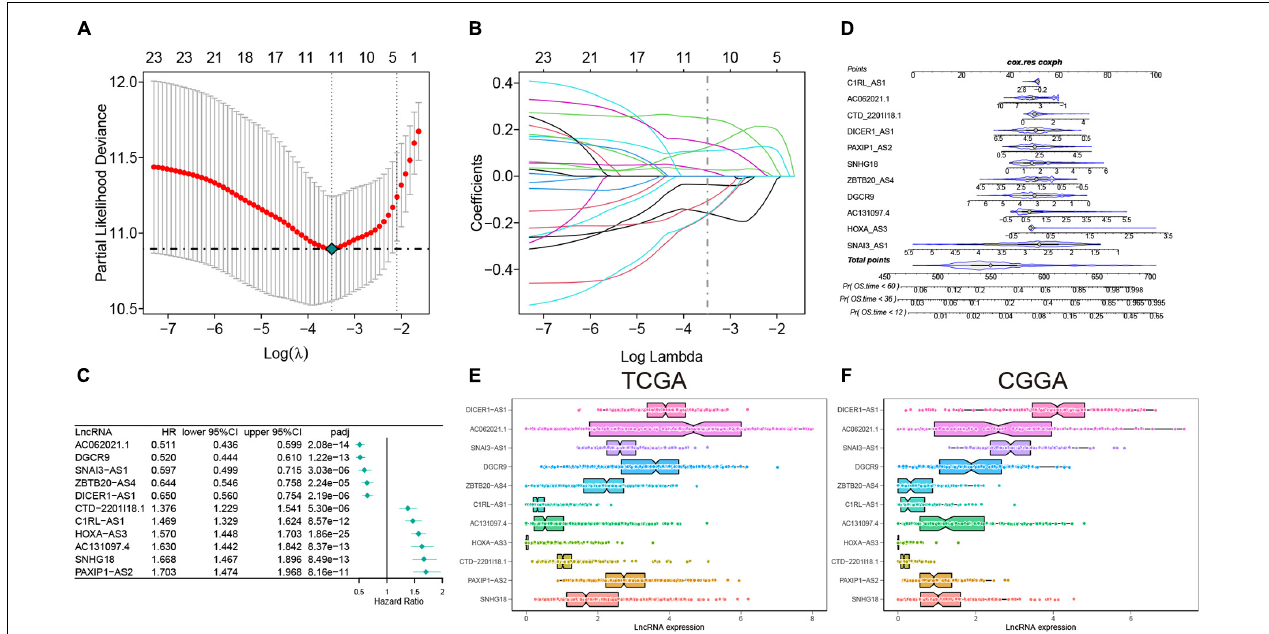
FIGURE 2 | The construction of risk model and identification of inflammation-related lncRNAs. (A) Partial likelihood deviation was plotted relative to the logarithm of lambda in 10-fold cross-validation. (B) The trajectory graph of each variable. (C) The forest plot of univariate Cox regression analysis among 11 lncRNAs. (D) Nomogram to predict the 1–, 3–, and 5-year OS for 11 lncRNAs. (E,F) The expression of 11 lncRNAs in the TCGA and CGGA cohorts.